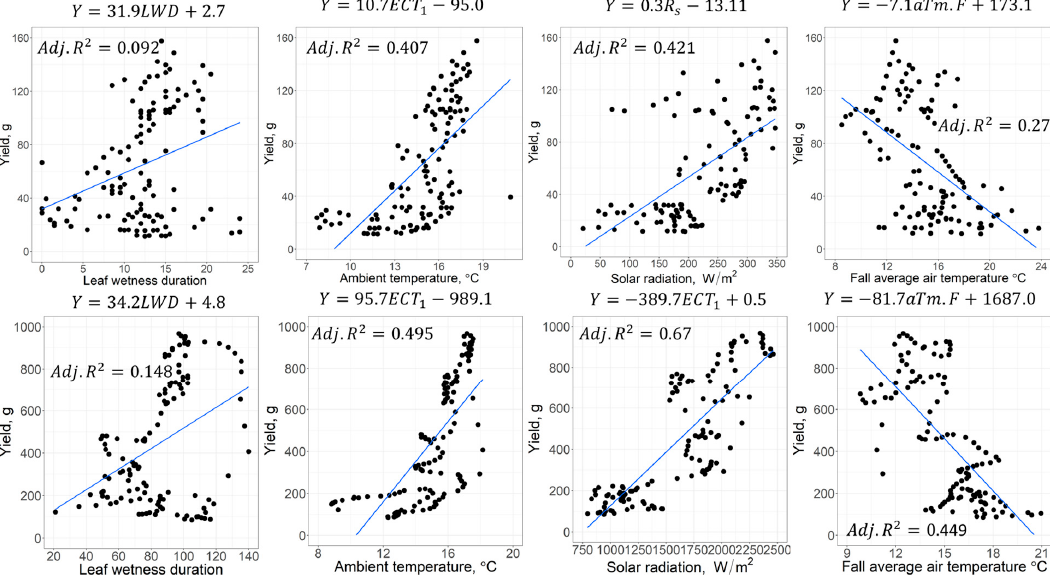
Figure 6. Regression plots for the significant parameters on a daily scale ( top ) and 7-day moving window ( bottom ).